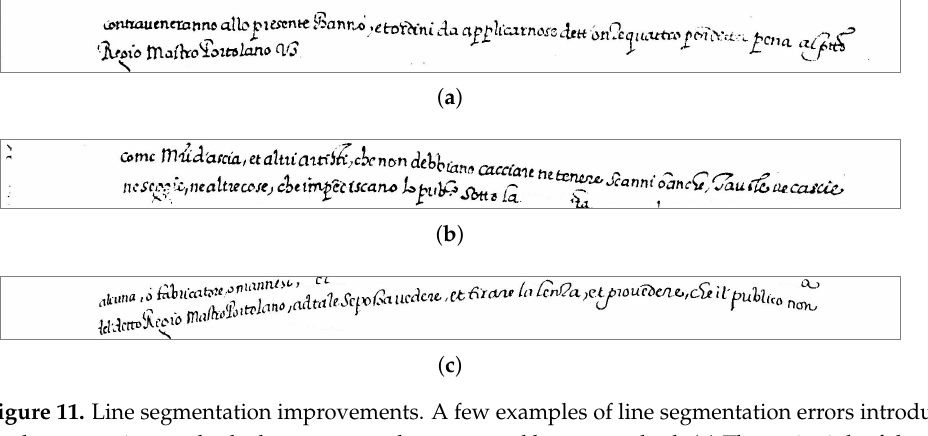
Figure 11. Line segmentation improvements. A few examples of line segmentation errors introduced by the competing methods that are correctly segmented by our method. ( a ) The entire ink of the next line is included in the current line, ( b ) some of the ink from the next line is included in the current line, ( c ) some of the ink from the previous line is included in the current line.